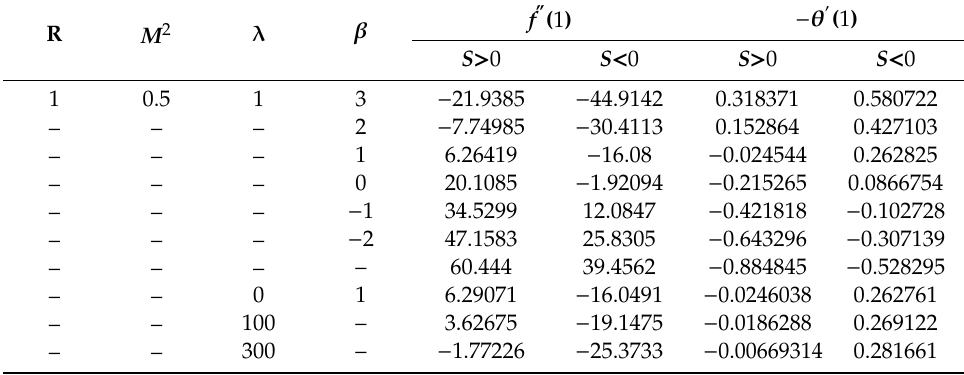
Table 4. Numerical results of skin friction coe ffi cient and Nusselt number for γ Al 2 O 3 − C 2 H 6 O 2 R M 2 λ β